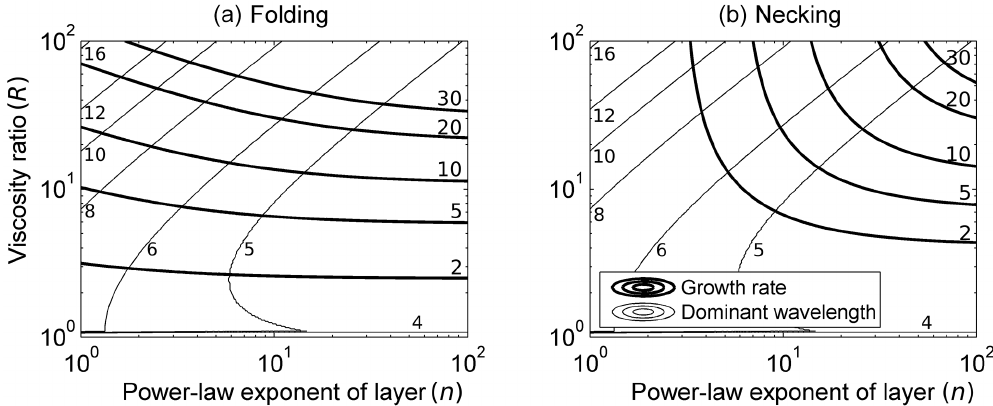
Figure 14. Contours of the ratio of dominant wavelength to layer thickness (thinner lines) and dimensionless amplification rate (growth rate; thicker lines) for folding (a) and necking (b) as a function of the reference viscosity ratio ( R) and the power-law stress exponent of the layer ( n ). The embedding medium is linear viscous ( n m = 1). For folding the amplification rates are significant even for small values of the power-law exponent (<5), whereas for necking the amplification rates are insignificant (<10) for power-law exponents <10.